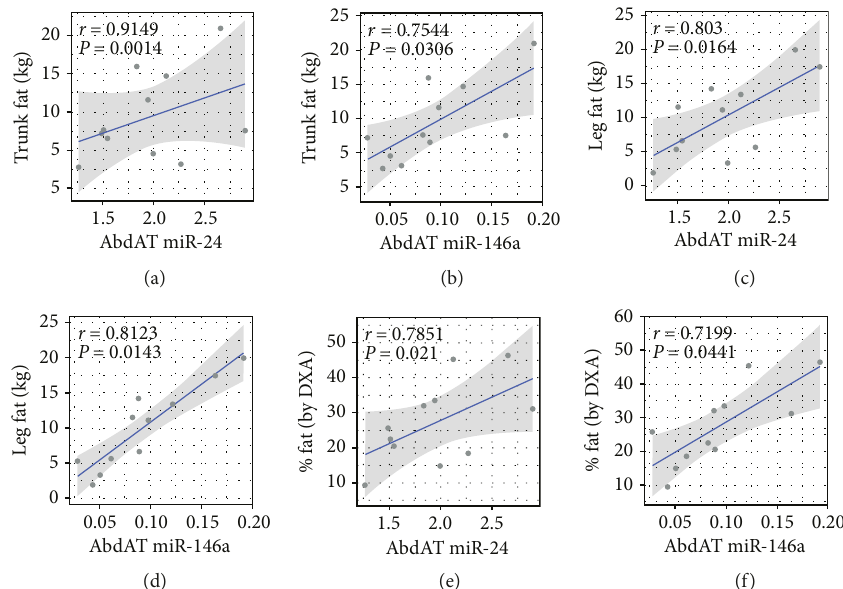
Figure 2: Additional measures of adiposity correlate with abdominal adipose tissue (AbdAT) miR-24 and miR-146a. Partial correlation analysis identi fi ed signi fi cant associations between speci fi c AbdAT miRNAs and measures of adiposity (a – f). Correlation scatterplots display the − Δ Ct data from di ff erentially expressed AbdAT miRNAs and were generated with the R package ggplot2 . The reported partial correlation that controlled for age, gender, and ethnicity was calculated with the ppcor package. The blue line and gray band represent the linear fi t of the plotted values and the 95% con fi dence interval of the fi t,